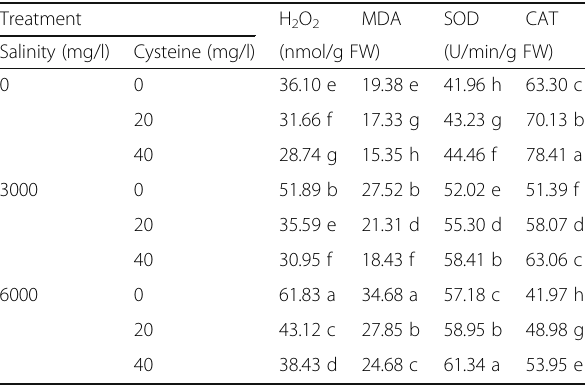
Table 3 Effect of cysteine (0, 20, and 40 mg/l) on H 2 O 2 , MDA (nmol/g fresh wt), and antioxidant enzyme activity (SOD and CAT) (U/min/g fresh wt) of soybean plant irrigated with saline water (0, 3000, and 6000 mg/l). Results are means of two successive